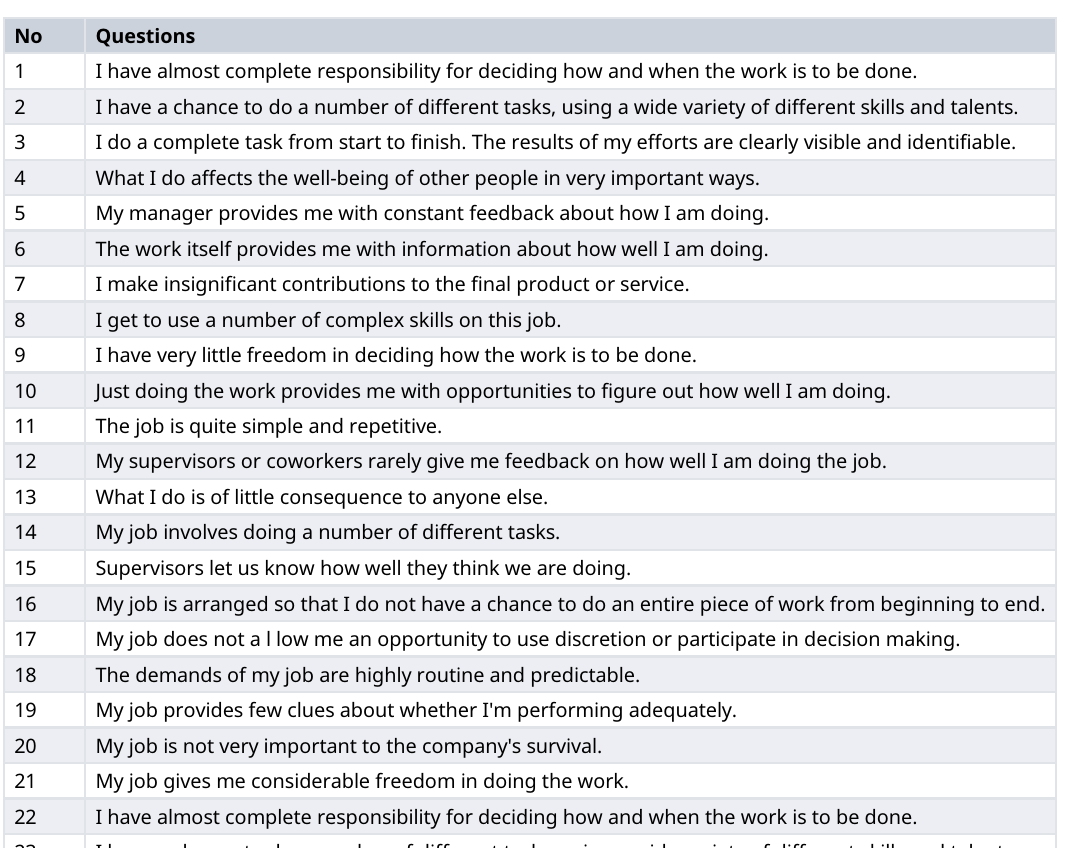
Table 1. Job diagnostic survey questions used in this study.